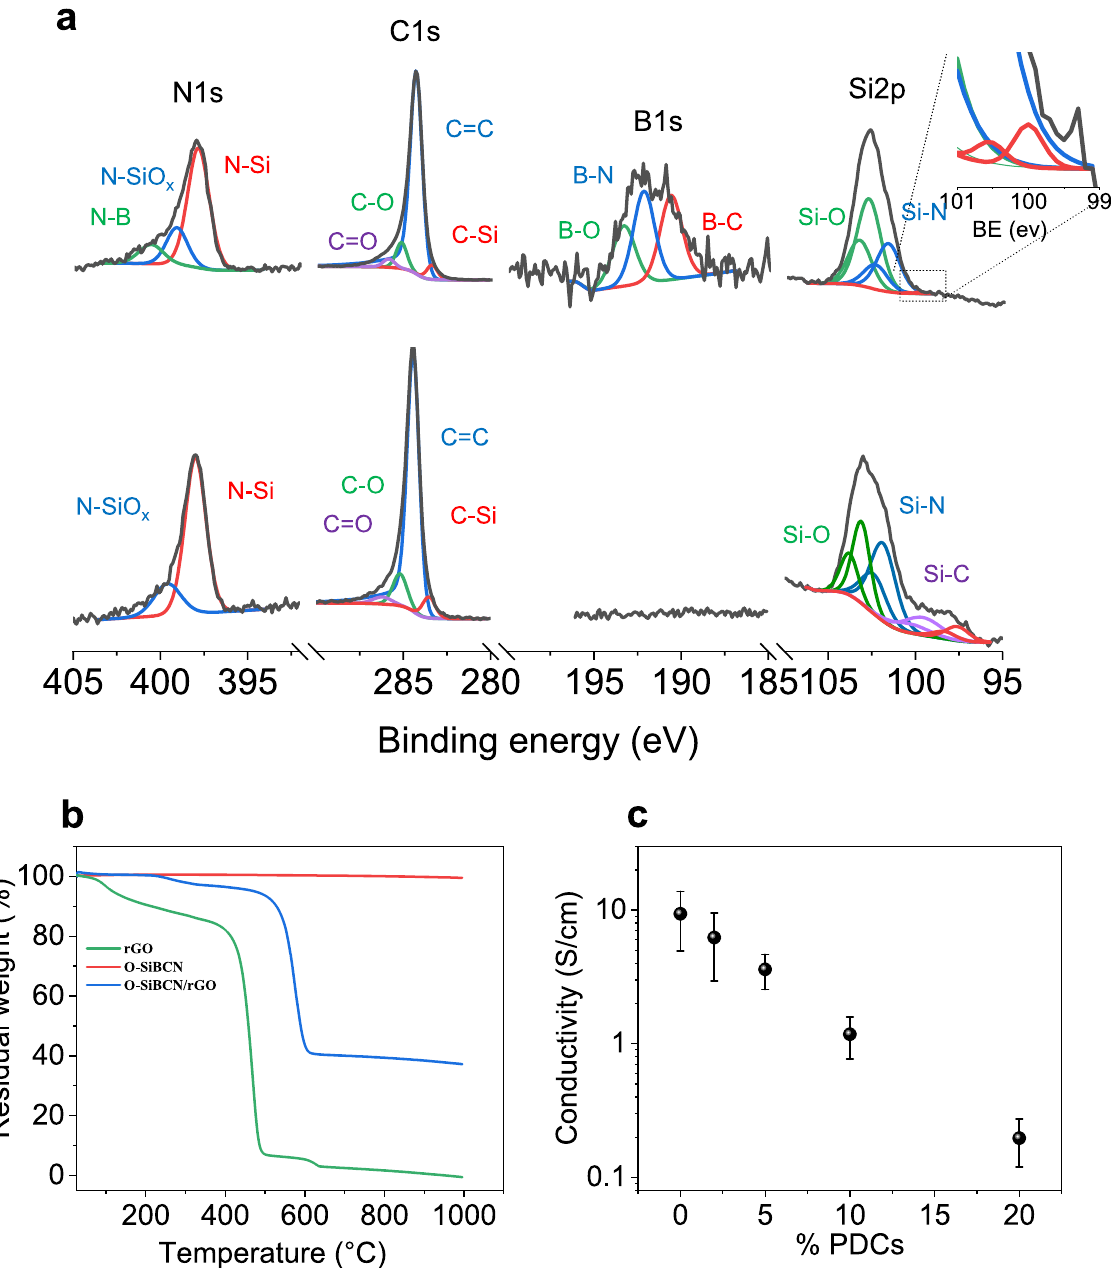
Figure 4. ( a ) XPS spectra of the N1s, C1s, B1s, Si2p regions of O-SiBCN/rGO (top) and O-SiCN/rGO composites (down). ( b ) TGA of the rGO foam, O-SiBCN ceramic, O-SiBCN/rGO composite under air up to 1000 °C and ( c ) electrical conductivity of PDCs/rGO composite